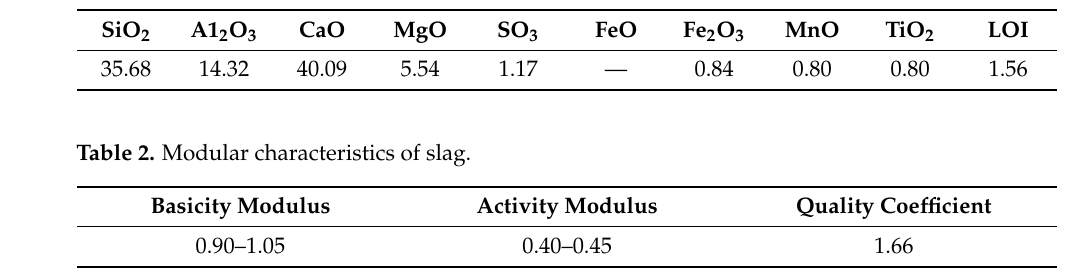
Table 1. Chemical composition of slag, %.